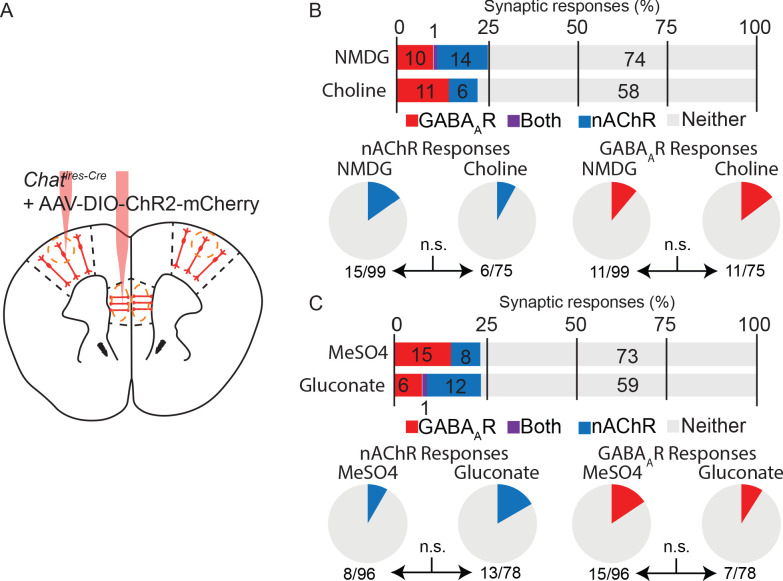
Difference in ChAT+ interneuron connectivity are not explained by differences in slicing solution or whole-cell internal recording solution.(A) Experimental design: Chatires-Cre mice were injected in both mPFC and M1 with AAV(8)-DIO-ChR2-mCherry, and whole cell voltage clamp recordings were obtained from layer 1 interneurons while optogenetically stimulating ChAT+ neurons. (B) Upper panel: summary quantification of cells showing synaptic responses, with GABAAR or nAChR-mediated responses differentiated by their reversal potential (−70 mV and 0 mV, respectively), and pharmacology. Numbers in the bar graph indicate the number of post-synaptic neurons in each category (n = 99 neurons from 7 Chatires-Cre mice for NMDG slicing solution, n = 75 neurons from 3 Chatires-Cre mice for choline cut solution, p=0.1049 for nAChR-mediated responses, p=0.4989 for GABAAR-mediated responses, Fisher’s exact test). Lower panel: comparison of cells showing nAChR-mediated responses (left) or GABAAR-mediated responses (right). (C) As in (B), but comparing cells recorded with CsMeSO4 or Cs-gluconate based internal solutions (n = 96 neurons from 5 Chatires-Cre mice with CeMeSO4, n = 78 neurons from 5 Chatires-Cre mice with Cs-gluconate, p=0.106 for nAChR-mediated responses, p=0.2524 for GABAAR-mediated responses, Fisher’s exact test).